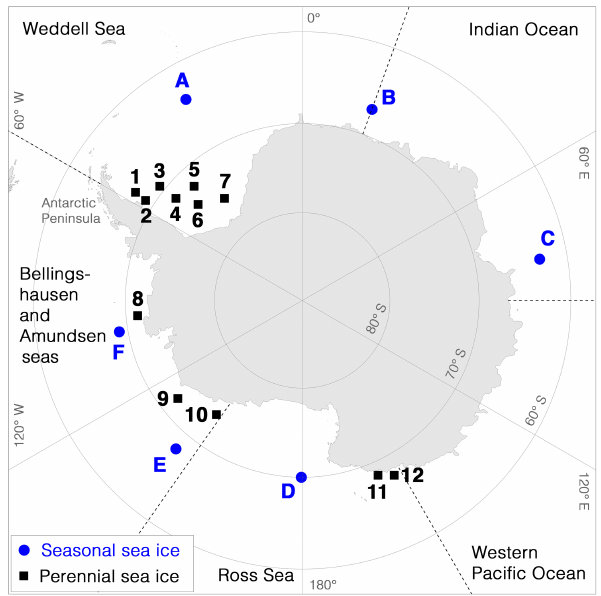
Figure 1. Map of Antarctica showing the 12 study locations in the perennial sea-ice zone (black squares, locations 1–12, same as used by Haas, 2001) and 6 study locations on seasonal sea ice (blue cir- cles, regions